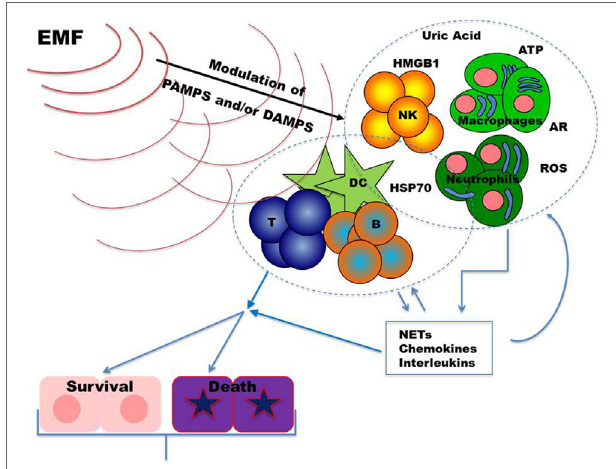
FiGURe 1 | Upon infection and/or tissue damage pathogen-associated molecular patterns (PAMPs) from microorganisms and damage-associated molecular patterns from injured cells alert the immune system. Stimulated innate immune cells, including neutrophils, macrophages, and NK cells, further amplify these danger signals secreting chemokines, cytokines, and other inflammatory mediators. The resulting inflammatory response sustains recruitment and activation of the adaptive immune system cells (T and B lymphocytes). Once an effective immune response is carried out, inflammation returns to homeostatic levels allowing tissue repair. Dysregulations in immune responses lead to chronic inflammation which may result in further tissue damage. Exposure to EMFs could modulate inflammatory responses by targeting, in different cell types, signal transduction pathways and/or molecules relevant to danger signals. Abbreviations: ARs, adenosine receptors; ATP, adenosine triphosphate; B, B cells; DC, dendritic cells; HMGB1, high mobility group box-1; HSP70, heat shock protein 70; NKs, natural killer cells; NETs, neutrophil extracellular traps; ROS, reactive oxygen species; T, T